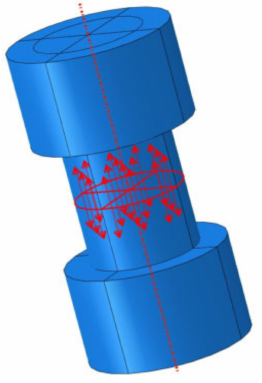
Figure 15. Application of preload force on bolt.